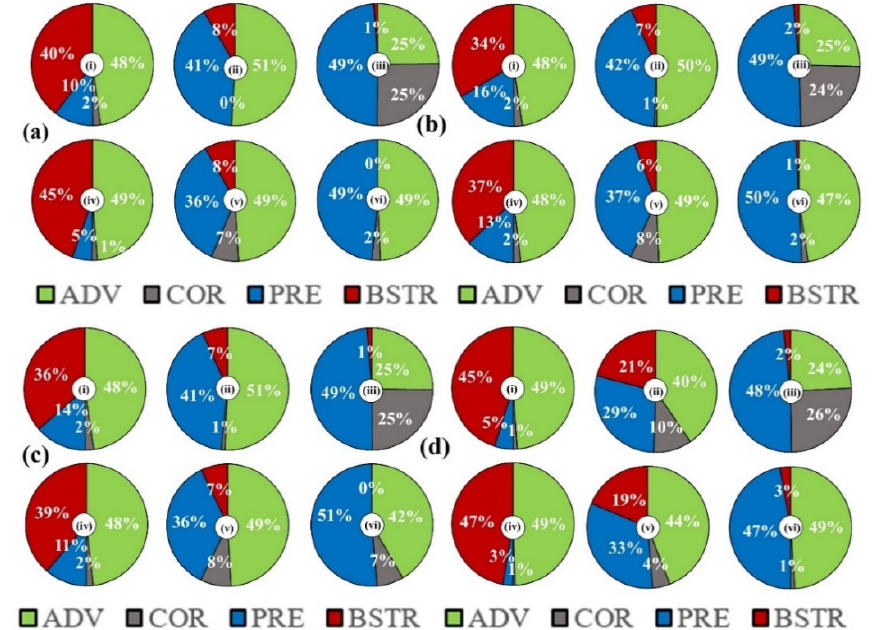
Figure 14. Depth ‐ averaged terms in the 2 ‐ D momentum balance equations [i.e., Equation (12)] during six tidal cycles (~72 h) at section P1. ( a ) Case 1, ( b ) Case 2, ( c ) Case 3, and ( d ) Case 4.